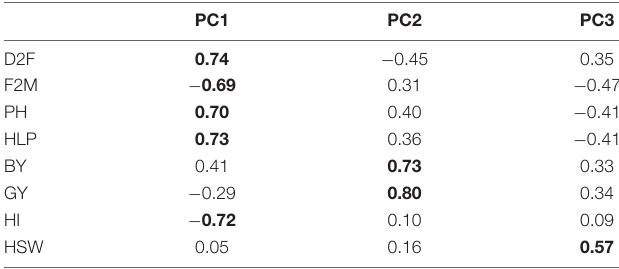
TABLE 2 | Correlations and contribution of different agronomic parameters to the first three principal components of the principal component analysis